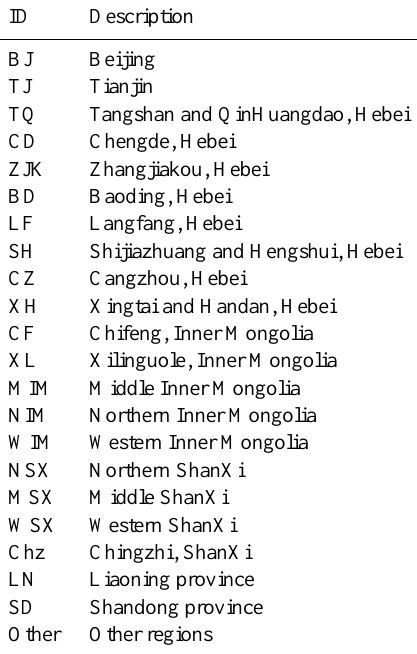
Table 1. Tagged regions and its ID. Table 2. Emission of major anthropogenic species (Unit: 10 3